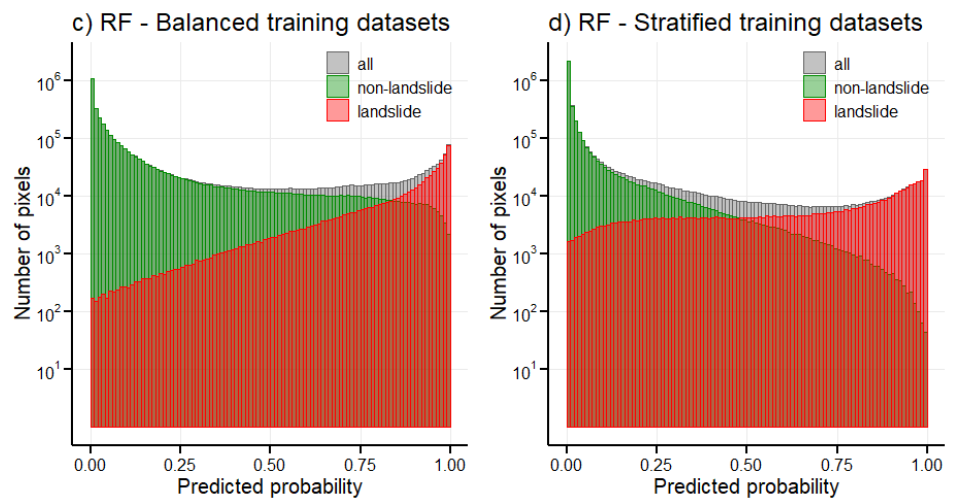
Figure 9. Histograms of predicted landslide susceptibility probabilities by logistic regression (LR; ( a , b )) and random forest (RF; ( c , d )) models trained on different types of datasets for differ- ent types of pixels—for all pixels in the background, for landslide pixels in the forefront, and for non-landslide pixels in the middle. Predicted probabilities for individual testing datasets from cross-validation were combined to create one dataset. Note the logarithmic scale on the vertical axes.